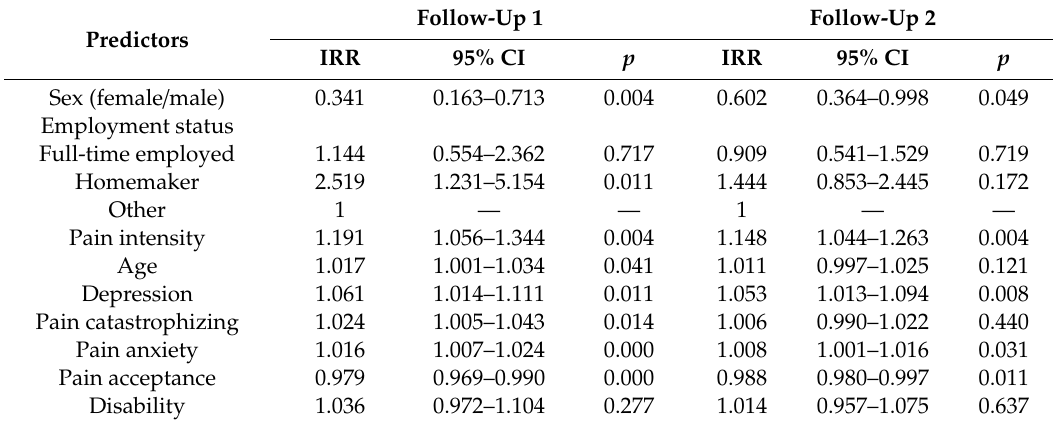
Table 4. Univariate negative binomial regression analysis of medication